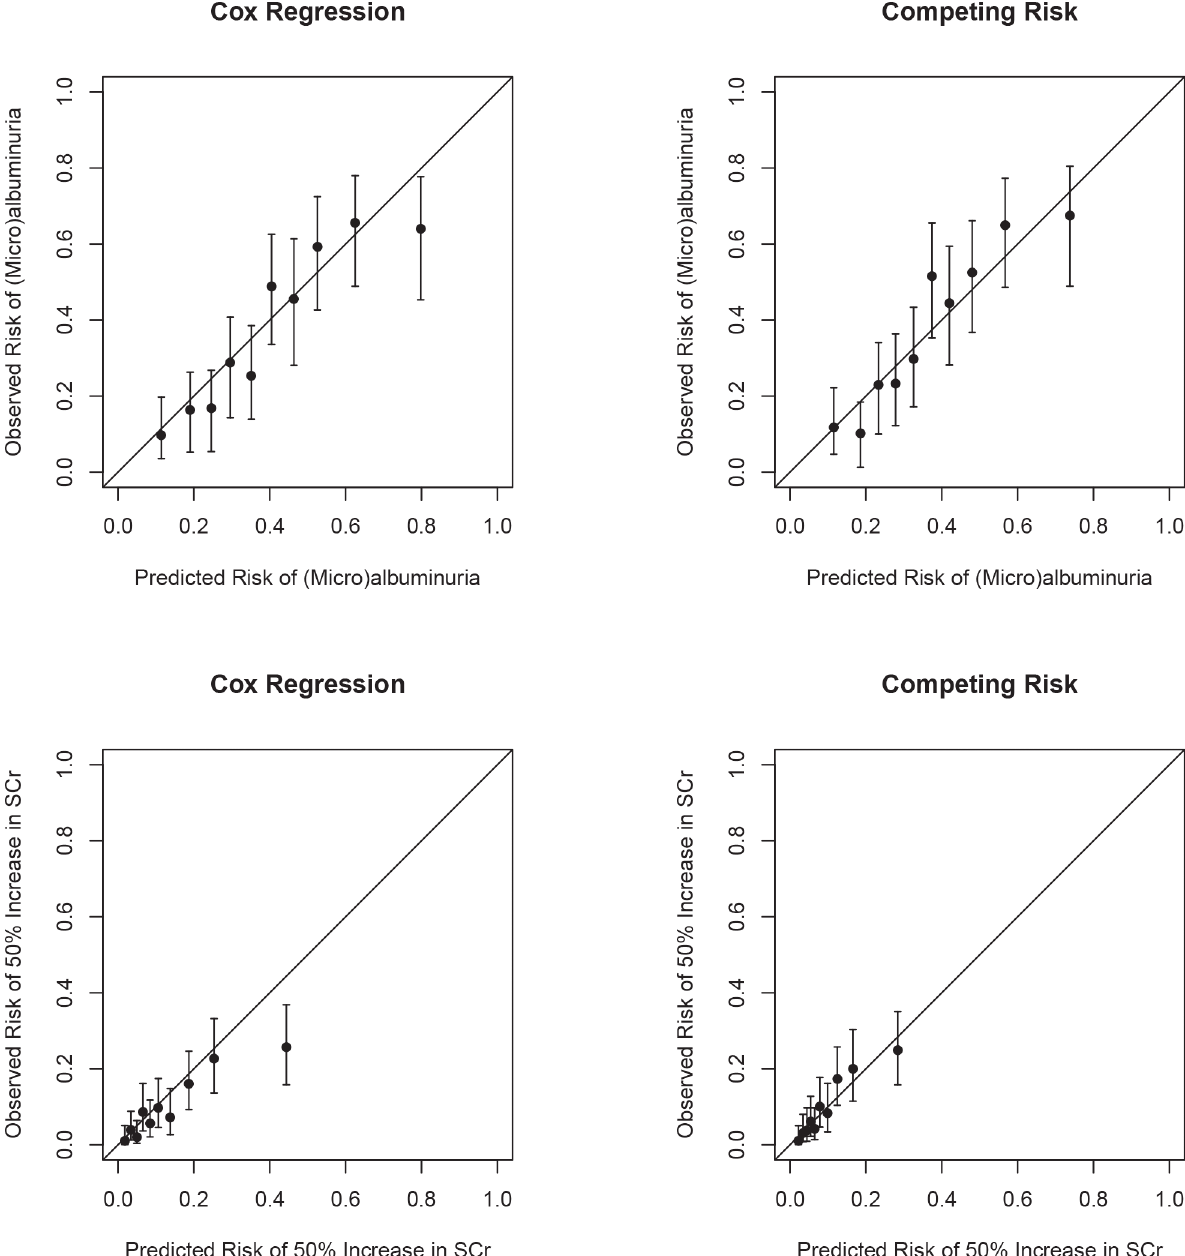
Fig 1. Calibration plots of mean predicted risk versus mean observed risk (cumulative incidence) and corresponding 95% confidence intervals presented according to deciles of predicted risk for the models predicting (micro)albuminuria and 50% increase in serum creatinine